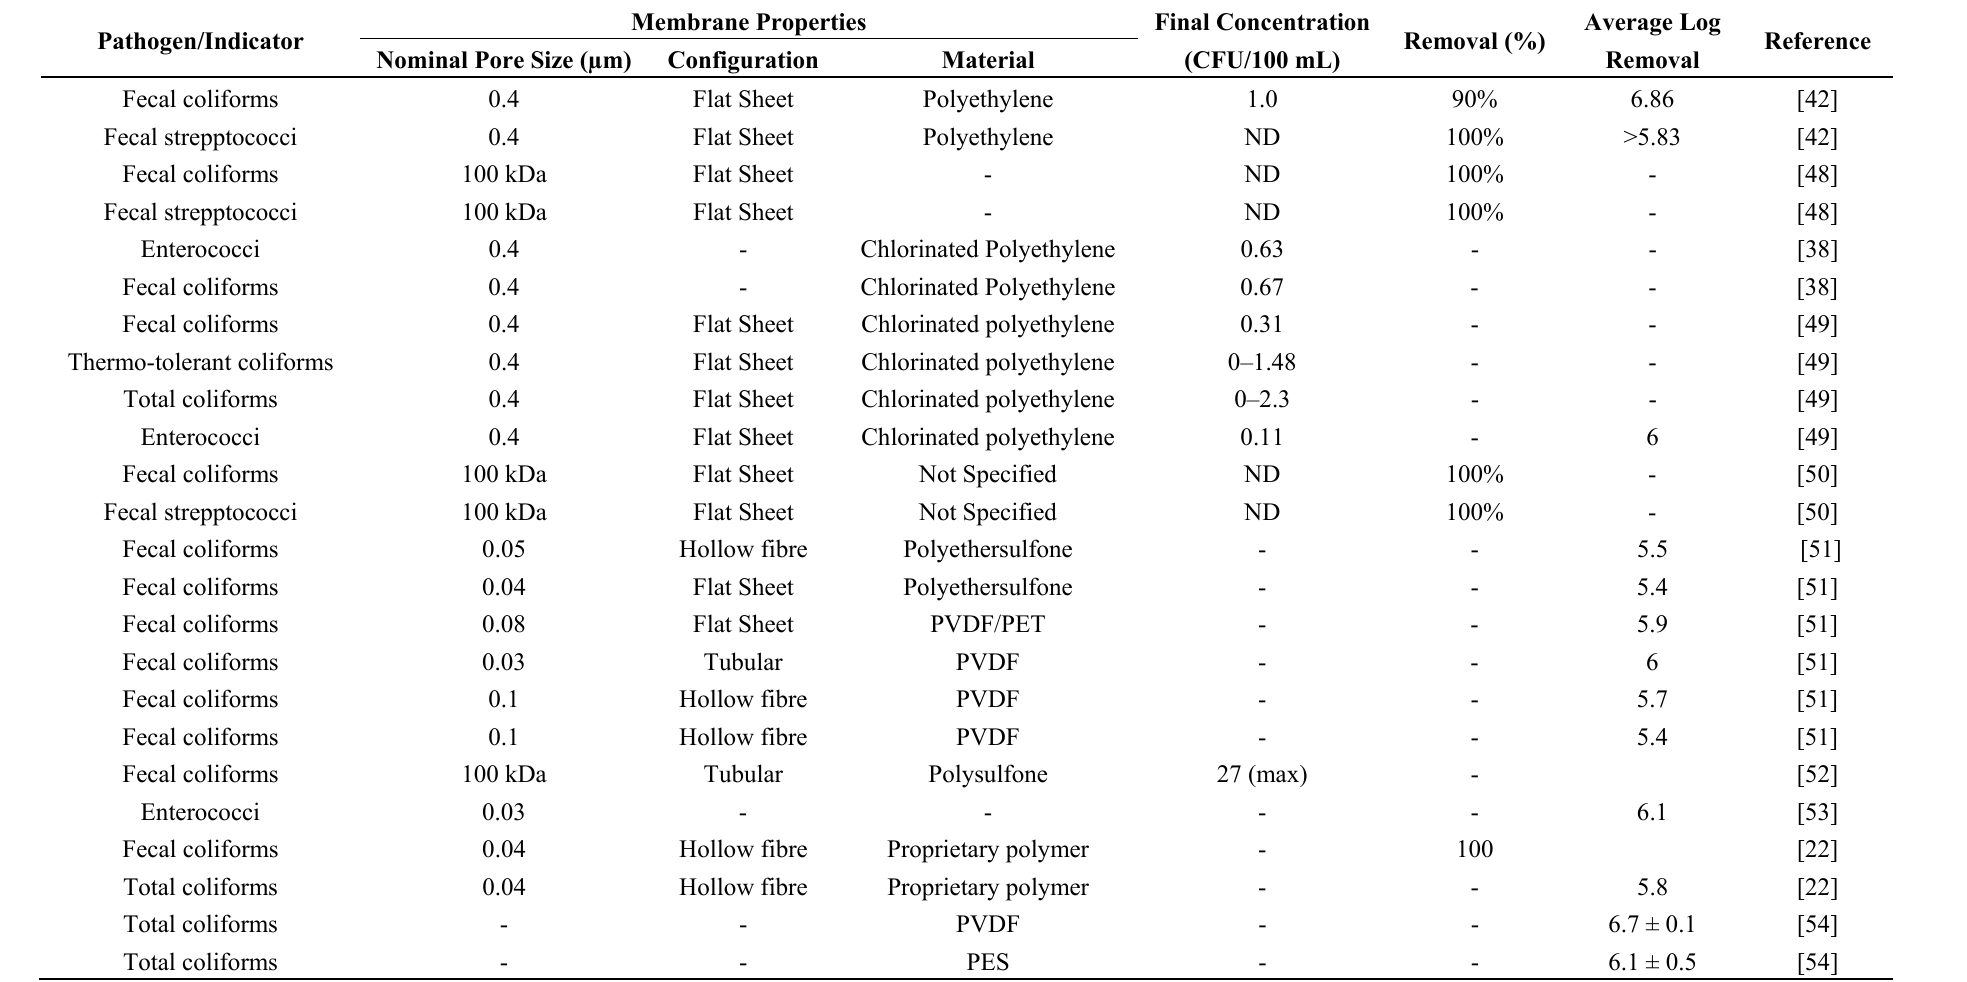
Table 2. Indicator bacteria removal by membrane bioreactor (MBR). CFU: colony forming